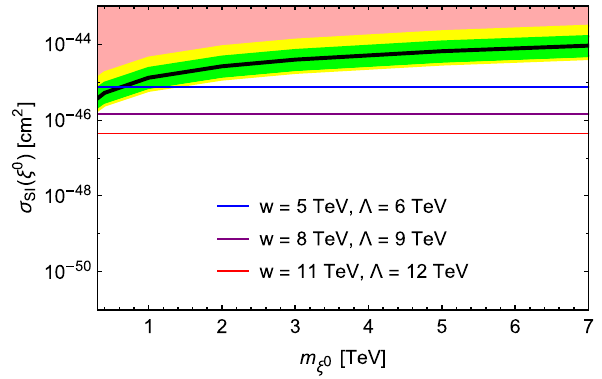
Fig. 9 The SI DM-nucleon scattering cross-section limit as a func- tion of DM mass according to the several choices of w,(cid:11) , where the excluded region is input as light